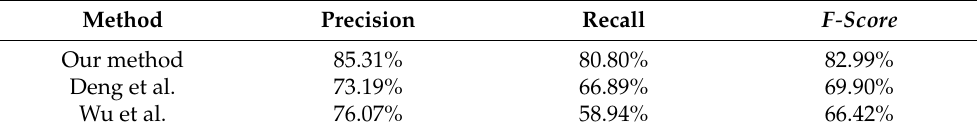
Table 2. Precision, recall, and F-score of various methods with respect to new road segment updates.